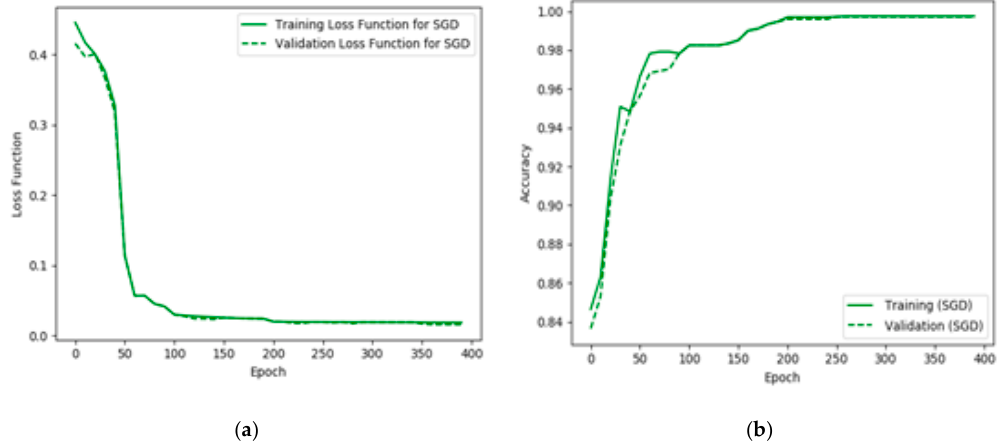
Figure 10. Variation of pre-training loss according to the number of epochs to fix the number of network hidden layer.